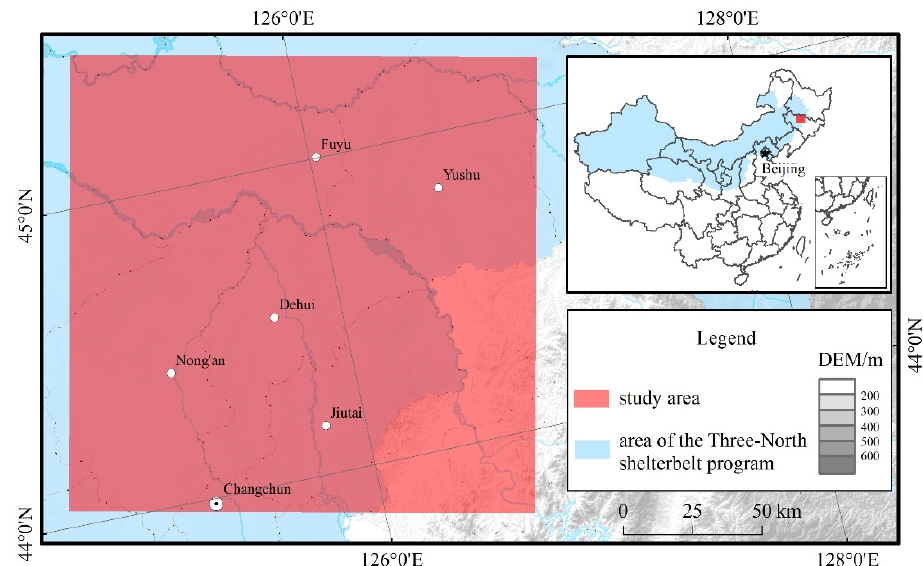
Figure 1. Location of the study